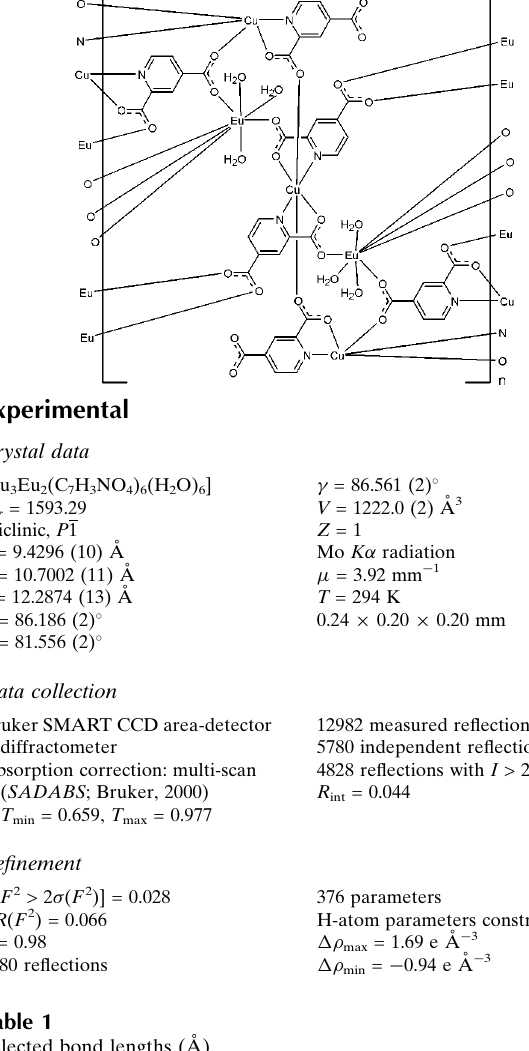
Selected bond lengths (A˚ ).